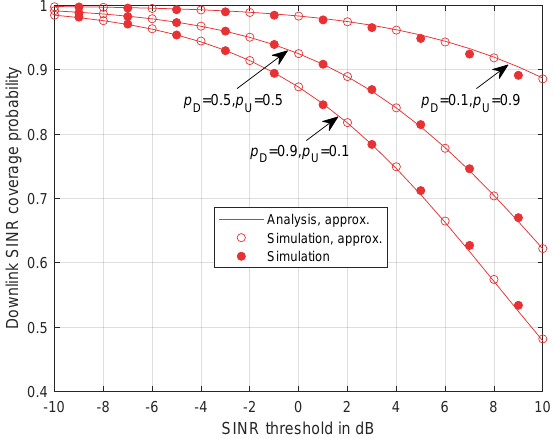
Figure 3. Downlink SINR coverage probability for flexible duplex and NAFD.